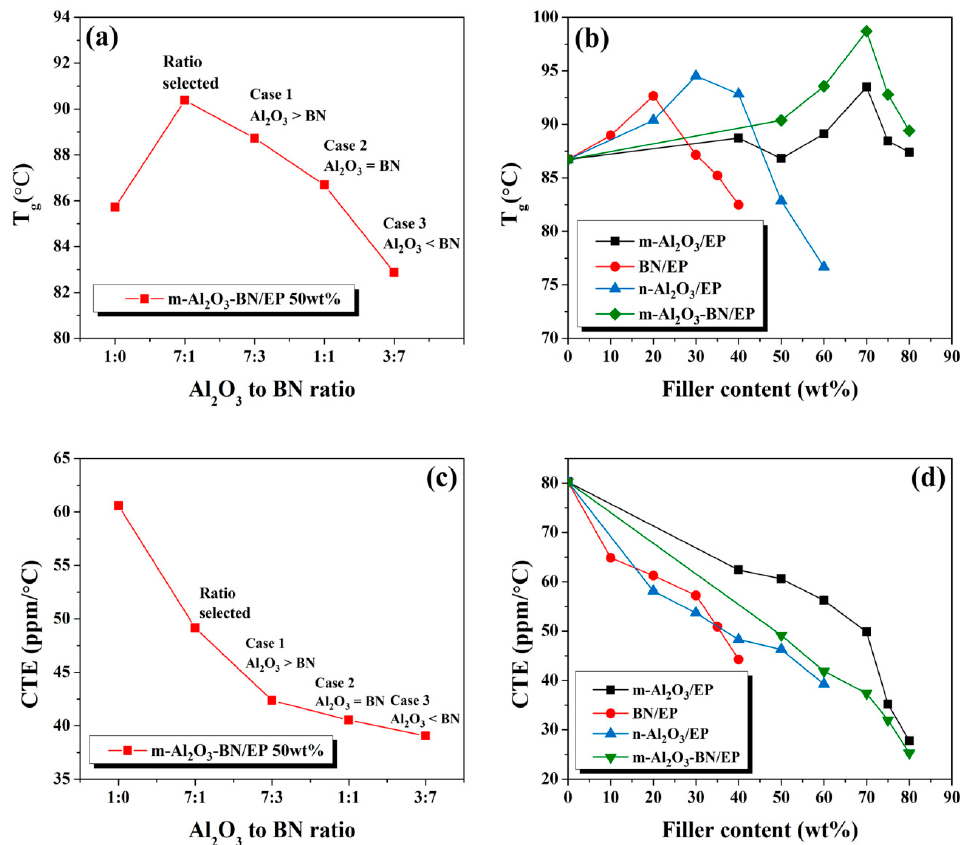
Figure 8. Glass transition temperature (T g ) of ( a ) m-Al 2 O 3 -BN/EP with 50 wt% as a function of Al 2 O 3 to BN ratio and ( b ) the distinct EP composites as a function of filler content. Coefficient of thermal expansion (CTE) below T g of ( c ) m-Al 2 O 3 -BN/EP with 50 wt% as a function of Al 2 O 3 to BN ratio and ( d ) the distinct EP composites as a function of filler content.